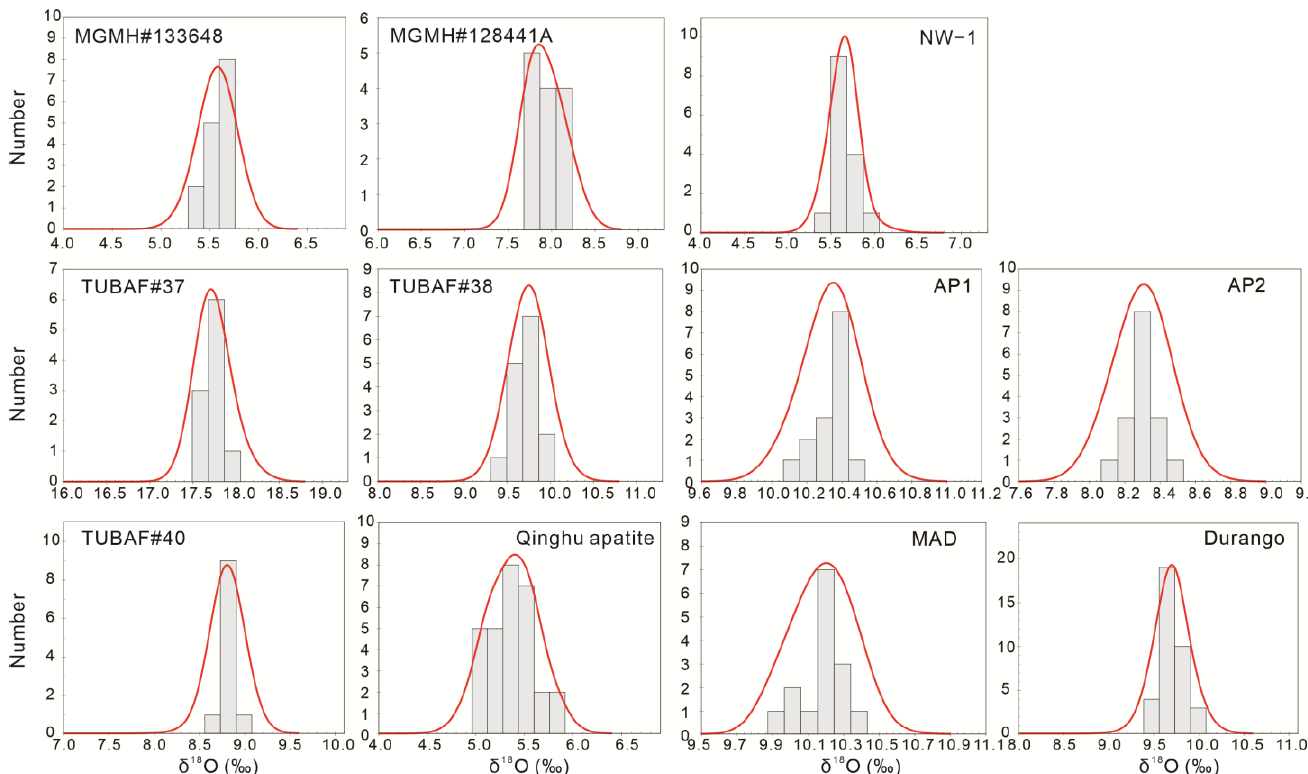
Figure 2. Probabilistic histograms of δ 18 O for the 11 samples used in this study, calibrated against Durango. The upper value in each diagram is the δ 18 O determined by SIMS in this study and the lower value is the recommended value. The errors are 2 SD.